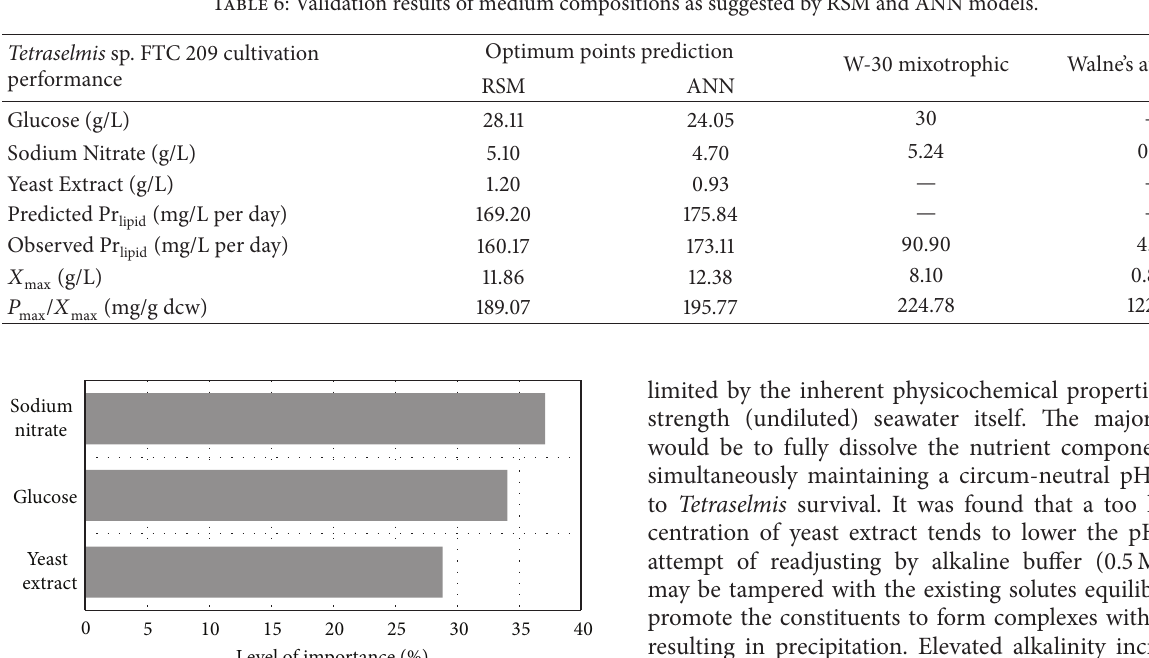
Table 6: Validation results of medium compositions as suggested by RSM and ANN models.